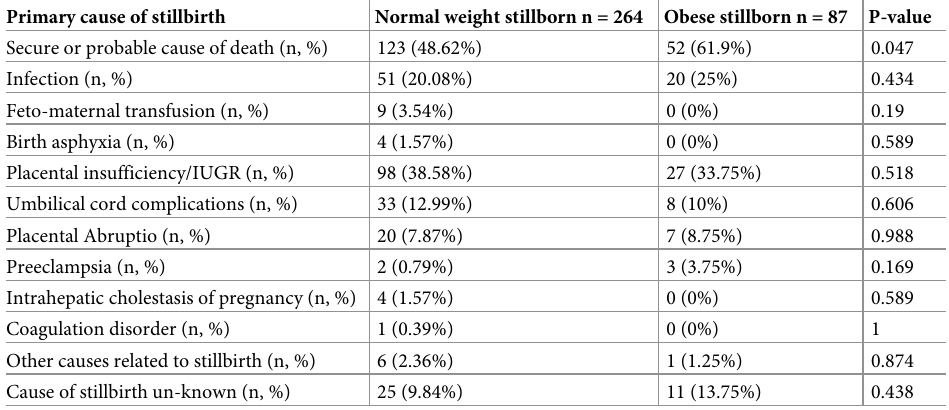
Table 3. Primary cause of term stillbirth; lean and obese women.